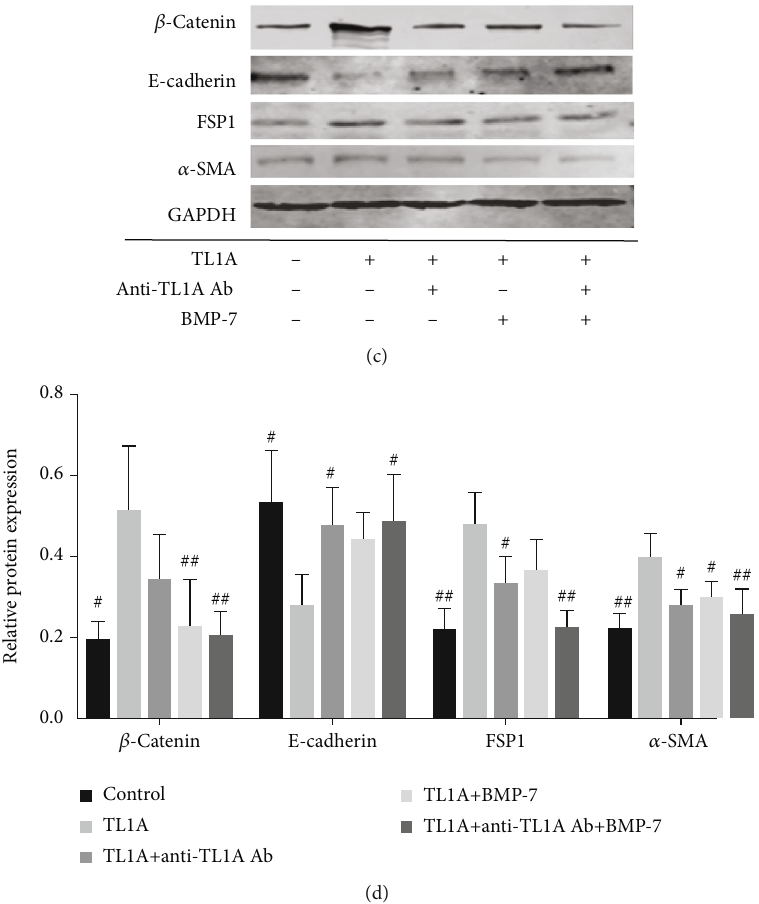
Figure 7: Inhibition of TL1A in intestinal epithelial cells in vitro using anti-TL1A antibodies and BMP-7. HT-29 cells were exposed to TL1A, anti-TL1A antibodies, and/or BMP-7, respectively. (a, b) The cells were probed with fl uorescently labeled antibodies against E-cadherin (red) and FSP1 (green); E-cadherin and FSP1 colocalization (yellow) (1000x) and the mean density of E-cadherin and FSP1 were detected by IPP software. (c, d) Western blot analysis of β -catenin, E-cadherin, α -SMA, and FSP1 in di ff erent groups of HT-29 cells. ∗ P < 0 : 05 , ∗∗ P < 0 : 01 , and ∗∗∗ P < 0 : 001 versus TL1A-treated cells. Data were given as mean ± standard deviation (SD). # P < 0 : 05 , ## P < 0 : 01 , and ### P < 0 : 001 versus TL1A-treated